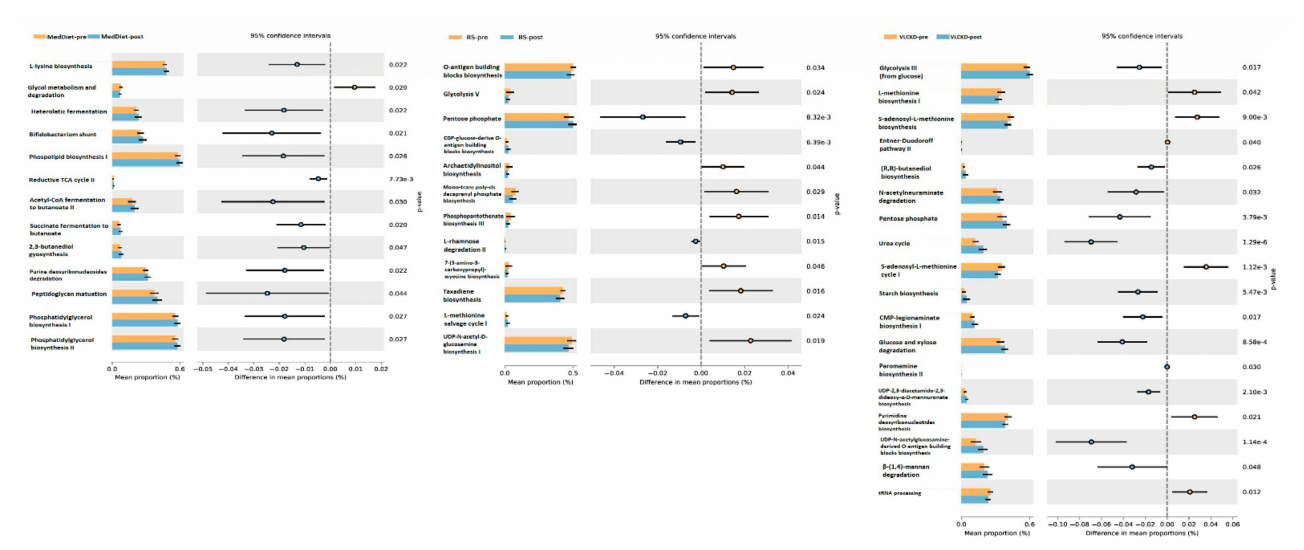
Figure 4. Relative abundance of the Kyoto Encyclopedia of Genes and Genomes (KEGG) pathways that changed significantly after each intervention. MD-pre: Mediterranean Diet at baseline. MD-post: Mediterranean Diet at the end of the intervention ( n = 21). BS-pre: Bariatric surgery at baseline. BS-post: Bariatric surgery at the end of the intervention ( n = 22). VLCKD-pre: very-low calorie ketogenic diet at baseline. VLCK-post: very-low calorie ketogenic diet at the end of the intervention ( n =